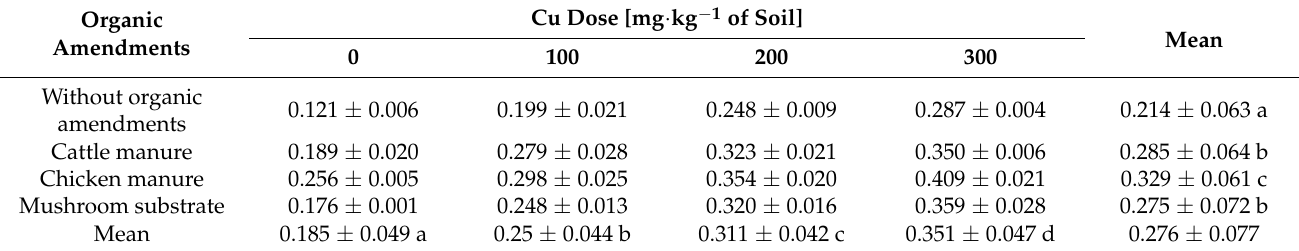
Table 5. Total copper uptake by cocksfoot at the sum for three years, mg Cu · pot − 1 (mean ±